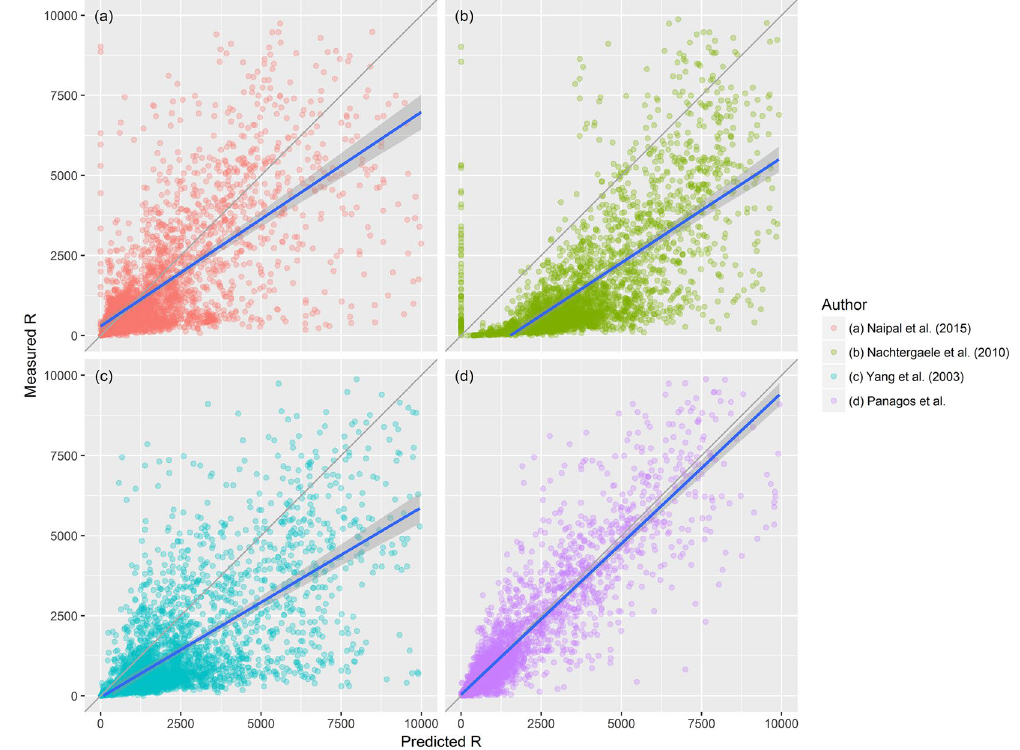
Figure 4. Comparison of predicted vs. measured R-factor values (values below 10,000 MJ mm − 1 ha − 1 yr − 1 ) for the three previous and the presented global models. Grey line is the result of an optimal model (Intercept = 0 and regression coefficient = 1); Blue line is the regression result of each model; Grey zone is the 99% confidence interval for the